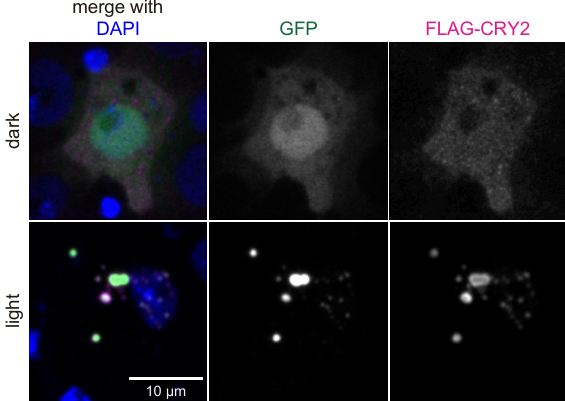
12 of 15 Appendix Figure A1. Laser intensity and LARIAT expression levels affect LARIAT clustering. Drosophila S2 cells expressing CIBN-MP and RFP-CRY2-V H H were analyzed through live-imaging as in Figure 3. ( A ) LARIAT clustering was stimulated with a 488 nm laser set to the indicated laser power for 300 msec at minute 0. Clustering was quantified with the coefficient of variation of cytoplasm fluorescence. Graph displays mean ± SD. n > 10 cells expressing between 20 and 49 relative amount of CIBN-MP + RFP-CRY2-V H H for each laser condition. ( B ) Cells exposed to 1 mW 488 nm laser power in ( A ) were